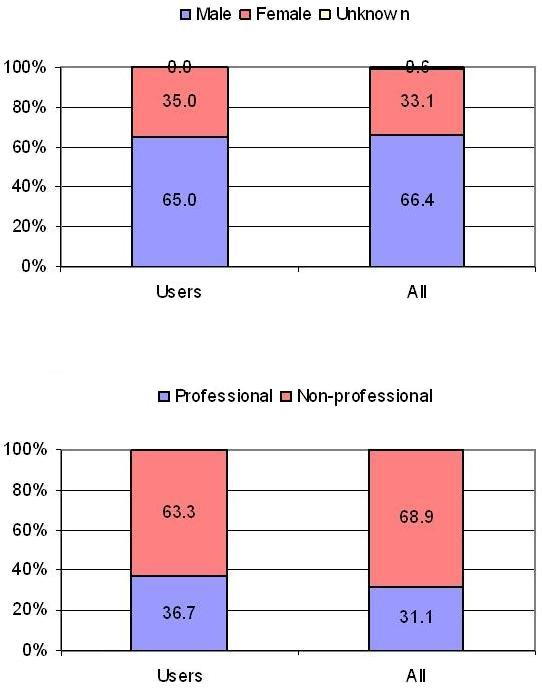
Gender and status distribution in the sample (n = 874) and user sub-sample (n = 520).